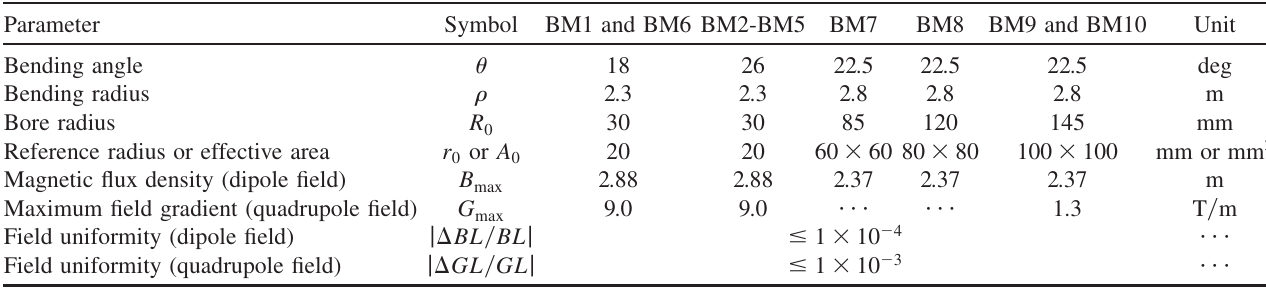
DESIGN OF A SUPERCONDUCTING ROTATING GANTRY . . TABLE II. Summary of parameters for the superconducting magnets, as determined by beam-optics calculations. Parameter